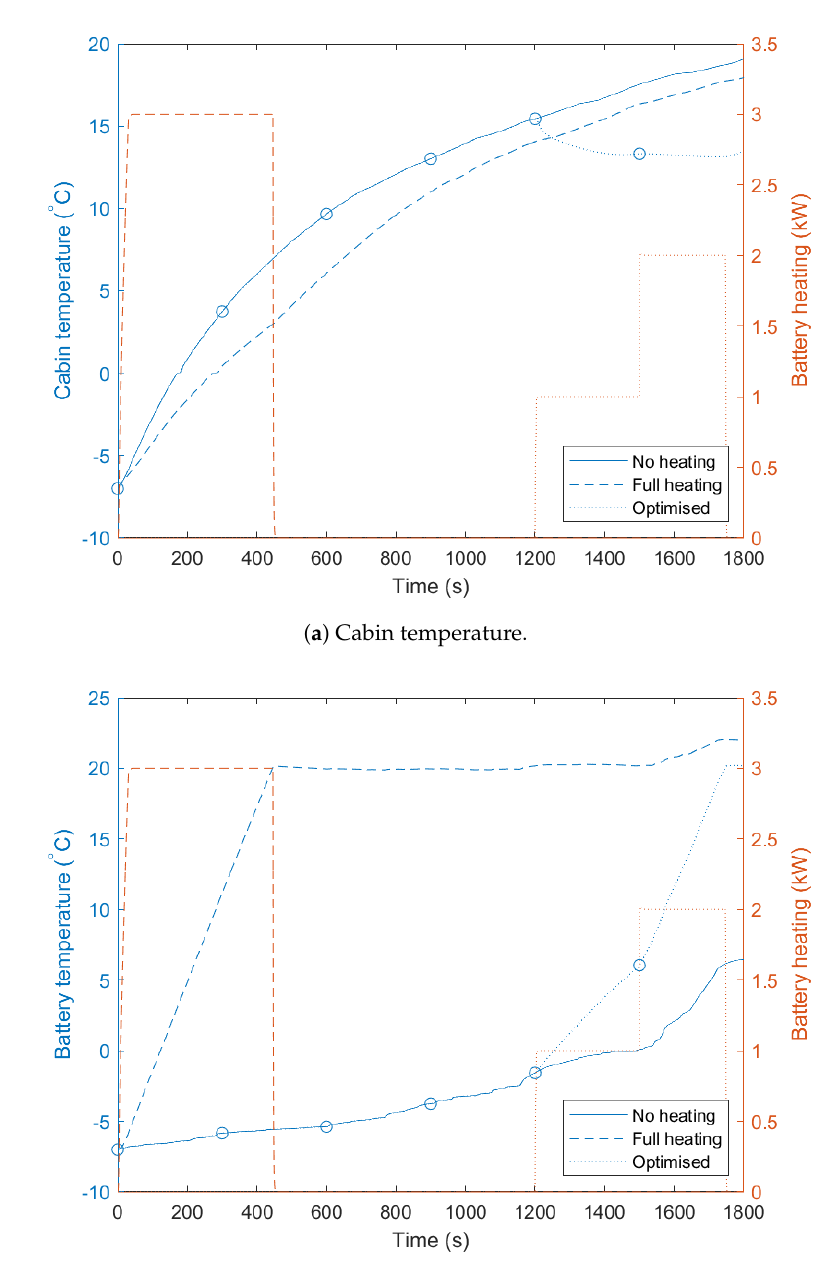
Figure 17. Battery and temperatures using baseline strategies compared to optimised heating trajectory at an ambient temperature of − 7 ◦ C. Circle markers indicate the location in time of each decision step. The solid line represents the no heating strategy, dashed line represents the full heating strategy, and the dotted line represents the optimised heating strategy. Blue lines indicate component temperatures, while the red lines indicate the heat delivered to the